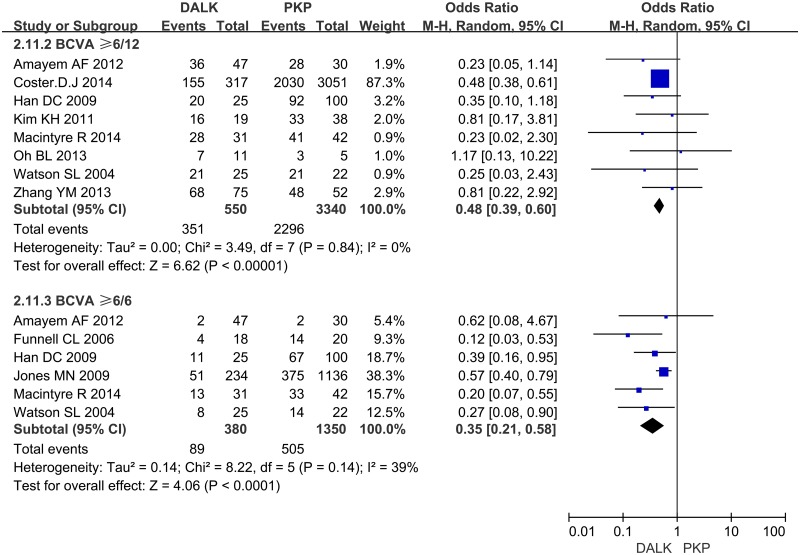
Forest plot comparing the rate of patients whose postoperative BCVA beyond 6/12 or 6/6 between DALK and PK.CI = confidence interval; SD = standard deviation; DALK = deep anterior lamellar keratoplasty; PK = penetrating keratoplasty.